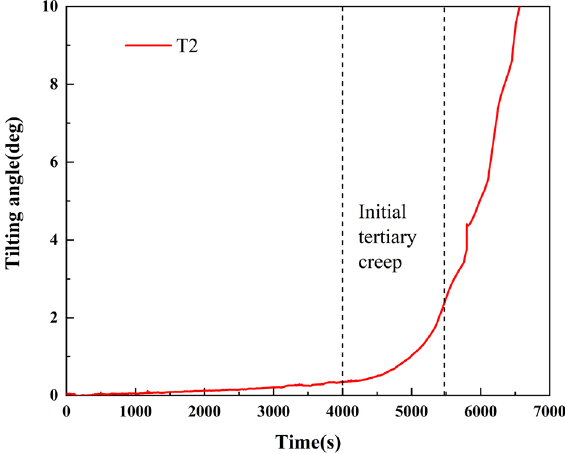
Figure 10. Tilting deformation curve of the retaining-wall locked segment landslide.